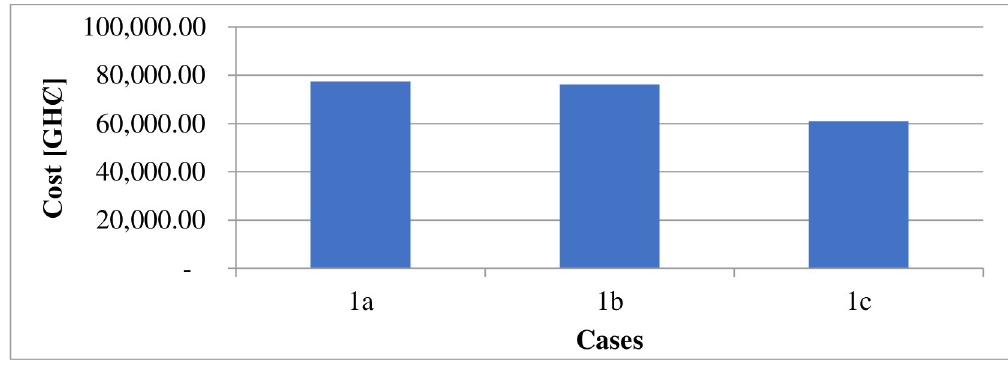
Fig 8. Cost of greenhouse emission–case 1.